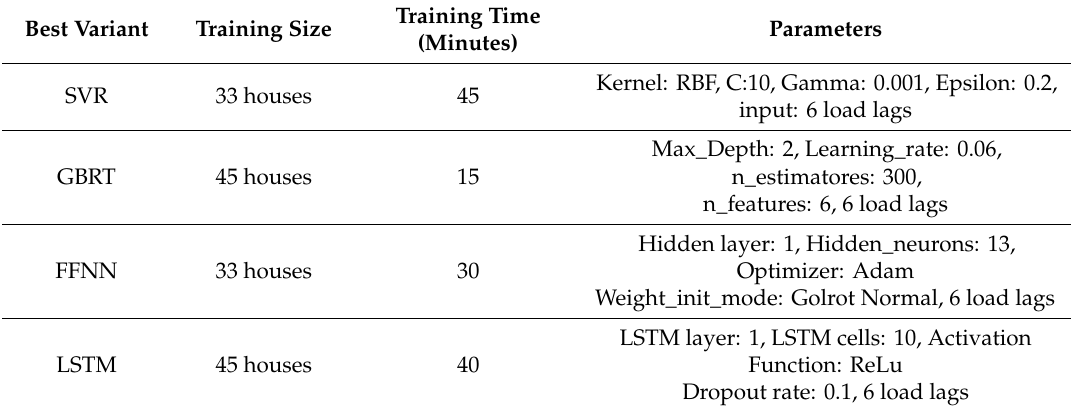
Table 2. Characteristics of the best-trained models.